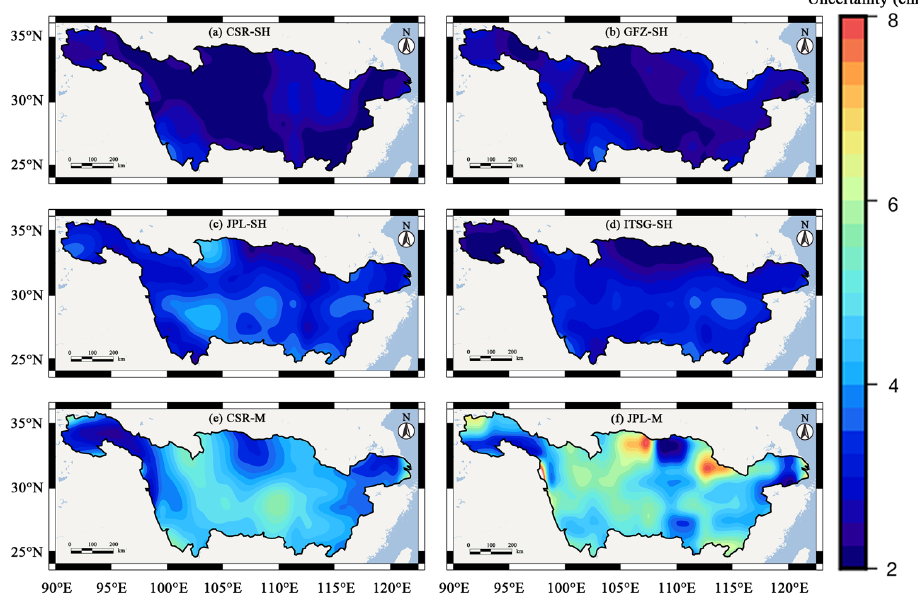
Figure 2. The spatial distribution of uncertainties of TWSC results in the YRB derived from CSR-SH, GFZ-SH, JPL-SH, ITSG-SH, CSR-M, and JPL-M solutions estimated by the GTCH method. To compare the total uncertainty level of these six TWSC results, the median of all the grid values of the uncertainty of YRB was used to represent the total uncertainty level of TWSC results from the different GRACE solutions. In ascending order according to the total uncertainty level, the order of these six GRACE solutions is CSR-SH (2.51 cm), GFZ- SH (2.73 cm), ITSG-SH (2.94 cm), JPL-SH (3.22 cm), CSR-M (4.62 cm) and JPL-M (5.20 cm).